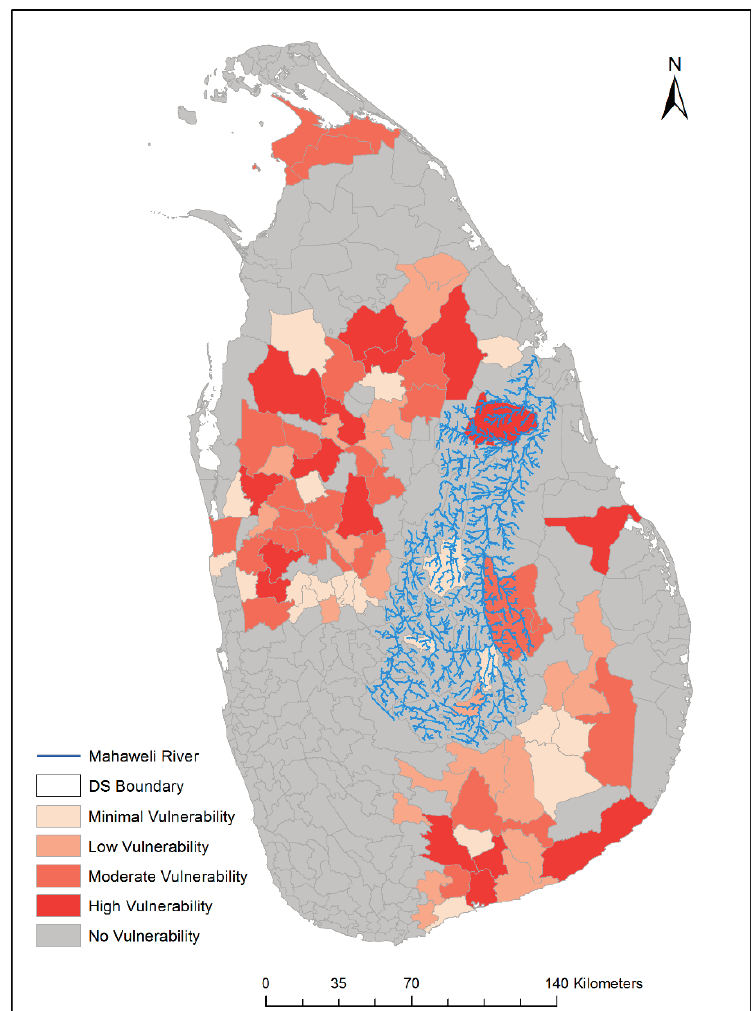
Figure 7. Paddy sector vulnerability to drought